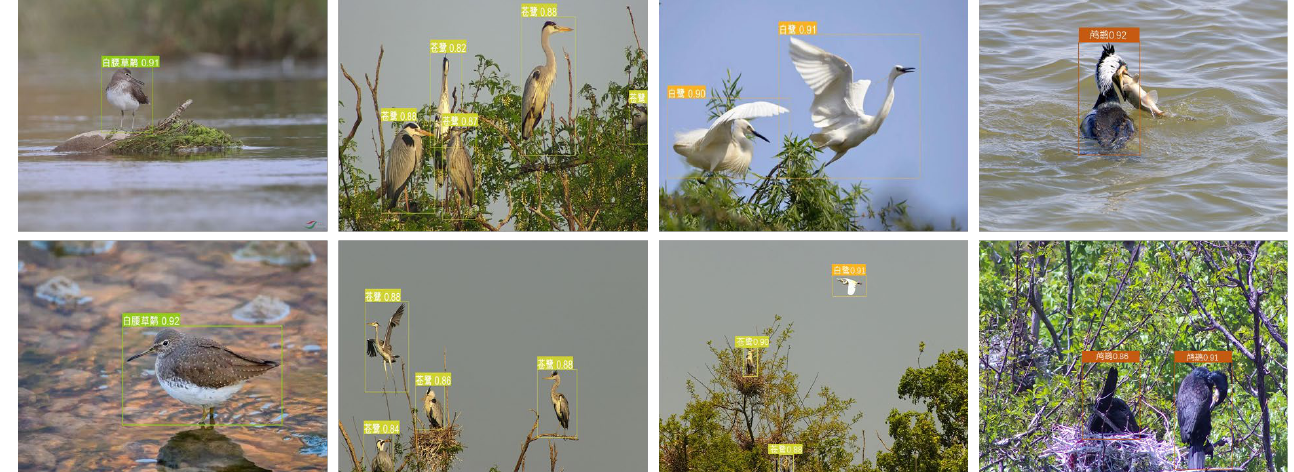
Figure 7. The detaching results obtained by optimized YOLOV5 model .